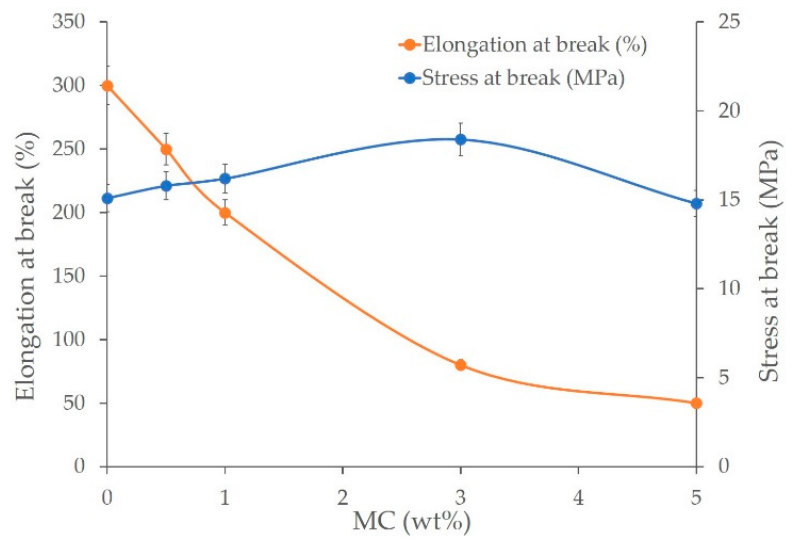
Figure 5. Tensile strength and elongation at break of the LDPE/MC composite films at various MC powder concentrations.